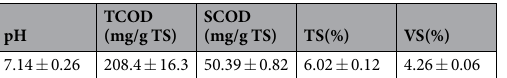
Table 3. Characteristics of swine manure used in this